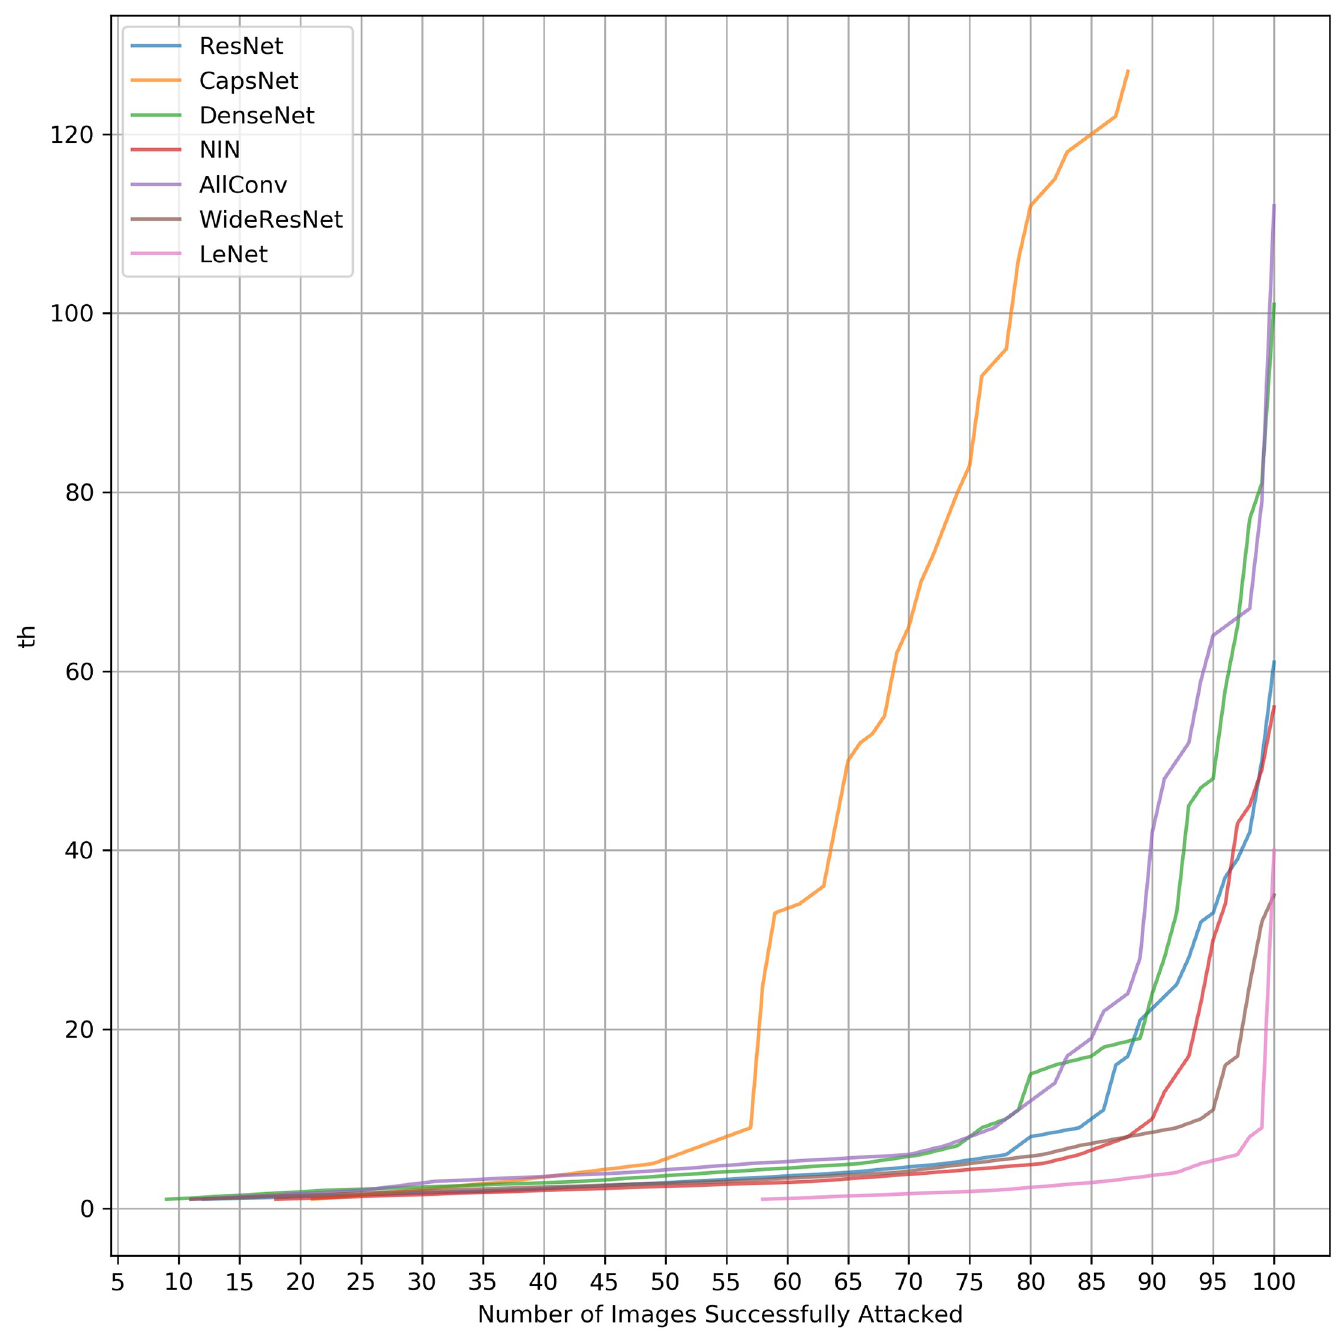
Fig 2. Adversarial accuracy per th for L 0